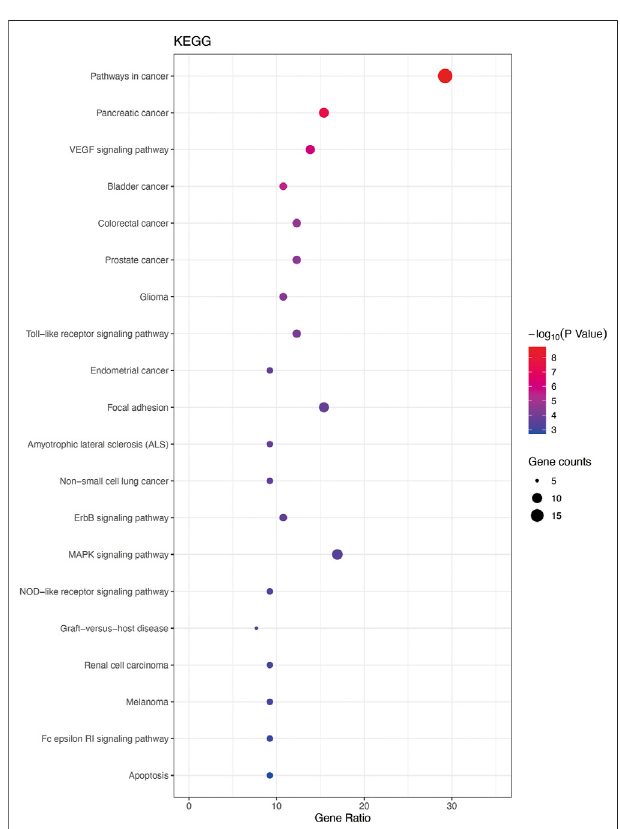
FIGURE 6 | Enrichment analysis for KEGG. Top 20 KEGG pathways listed by bubble chart according to the “ p -value ( < 0.05), Bonferroni correction.